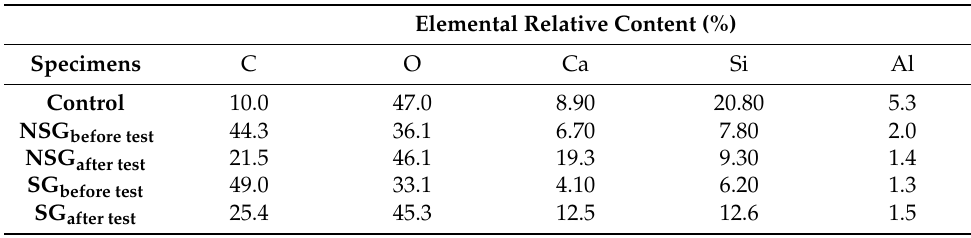
Table 4. Chemical compositions of recycled concrete without any treatment (control) and with NSG and SG biofilms before and after tubes Karsten